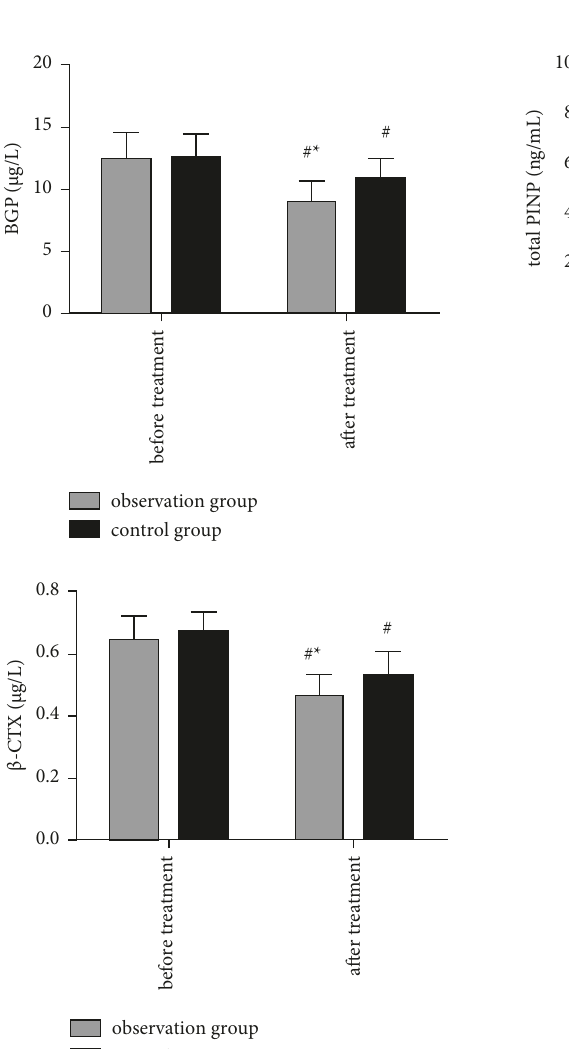
Figure 1: The changes of bone metabolism markers between the two groups with/without prebiotics/probiotics preparations (compared with the same group before the treatment, # P < 0 . 05; compared with the control group, ∗ P < 0 .